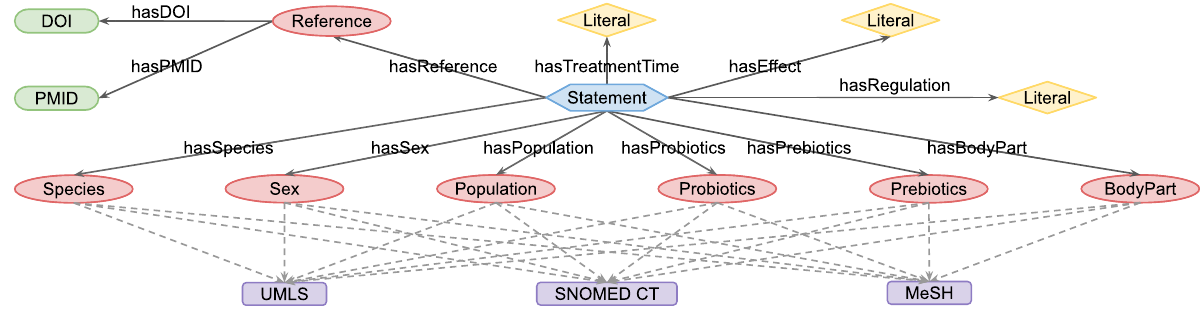
Figure 4. Entities, attributes and relations in ppstatement knowledge base. The blue hexagon represents assertion and the red ellipses represent terminologies. DOI and PMID (shown as green rectangles) are used as reference identifiers. Yellow diamonds are not entities but free texts. The entities are mapped to UMLS, MeSH and SNOMED CT (shown as purple rectangles) with URLs. Arrows indicate the direction of relations from source to target.